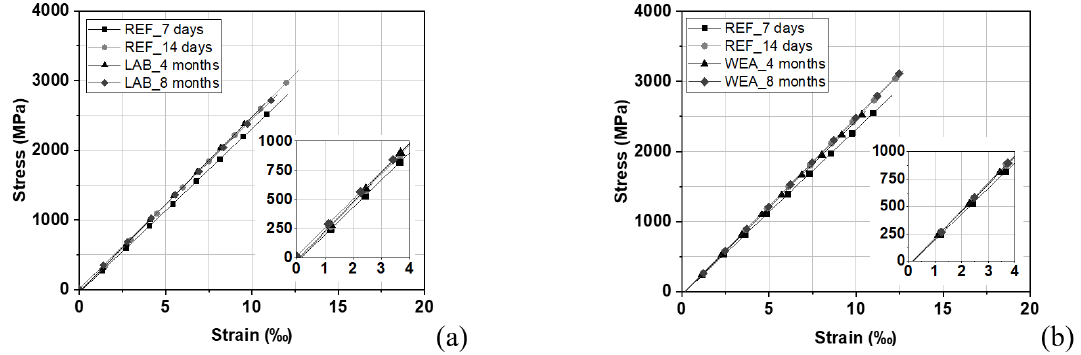
Figure 14. Stress versus strain relationship of CFRP composites maintained in laboratory environment (a) or exposed to weathering